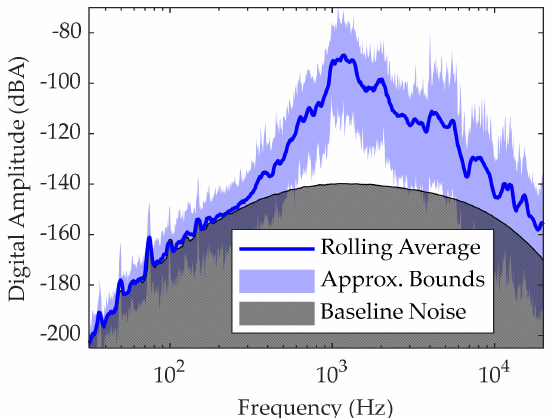
Figure 7. Amplitude spectrum of the audio signals recorded in the anechoic chamber. The rolling average shows the sound signal recorded in the frequency domain during actuator operation with approximate bounds to the recorded data